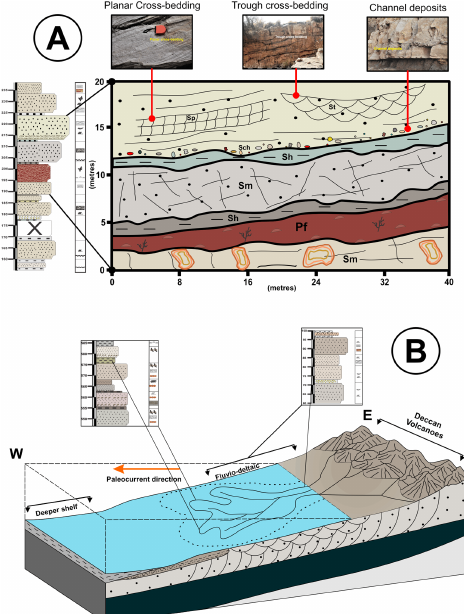
Figure 9. ( A ) Generalized section depicting the Pab architectural element b/w the Sh and Sm facies. This element consists of facies Sm, Sp, St, Sch, pf, and Sh. Showing the detailed lateral and vertical facies variations; and ( B ) depositional model of Pab sandstone in Eastern Sulaiman Ranges, Paki-